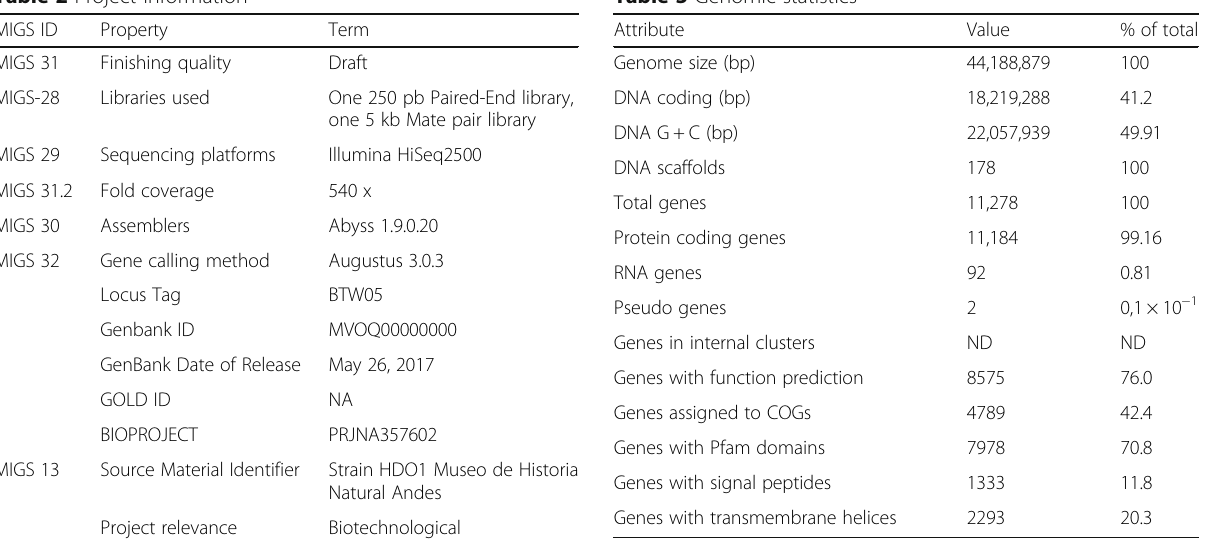
Table 2 Project